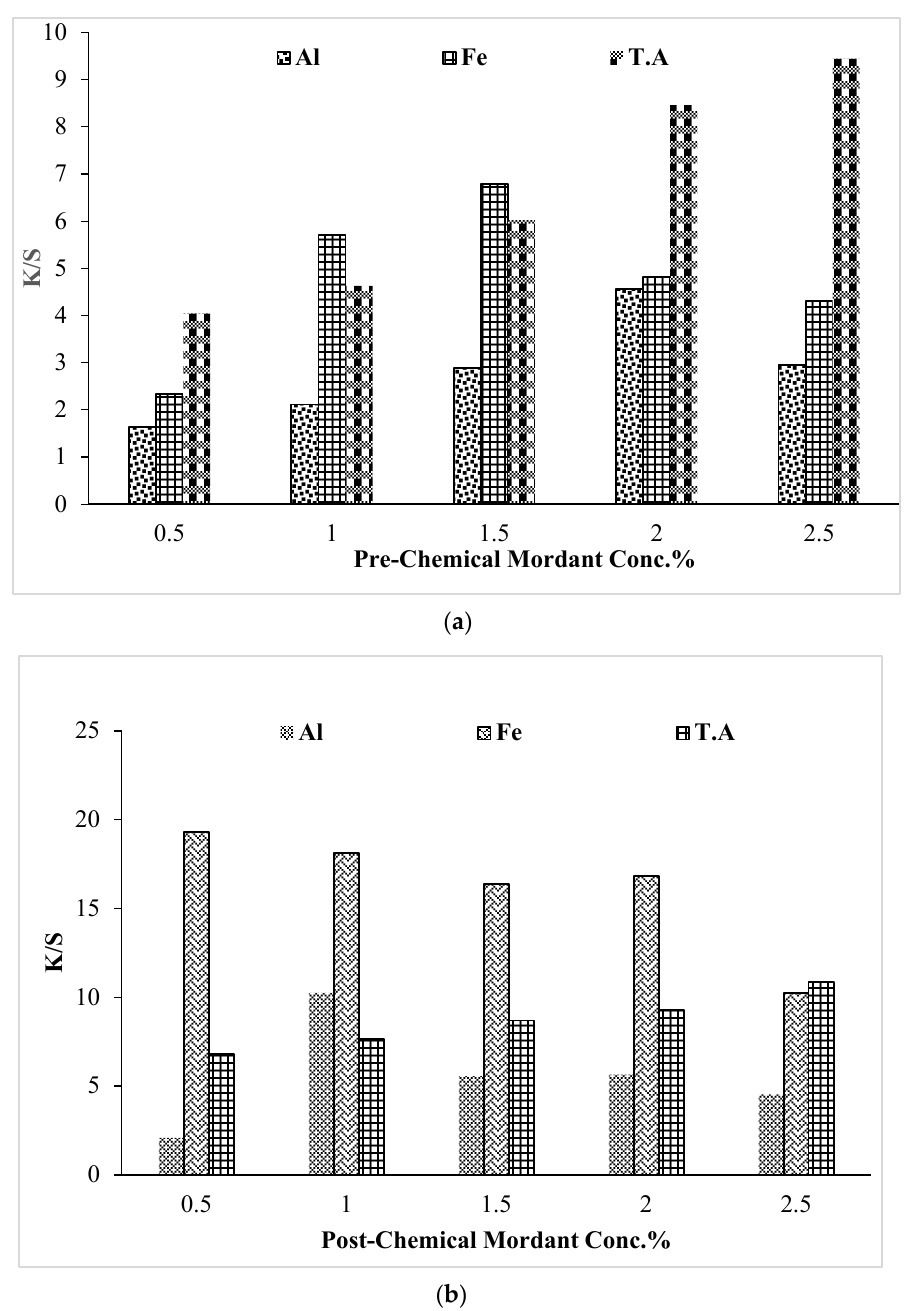
Figure 5. ( a ) Pre-chemical mordant of silk fabric with red sandalwood (RSW) powder at optimized conditions. ( b ) Post-chemical mordant of silk fabric with red sandalwood (RSW) powder at optimized conditions.